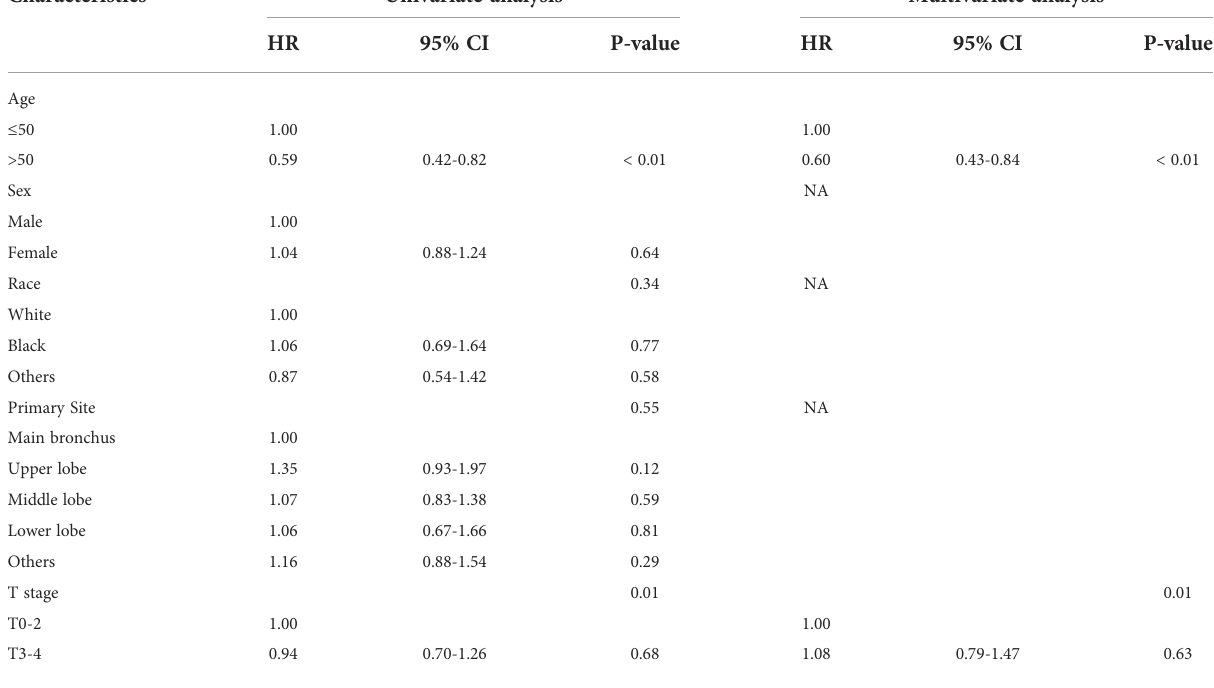
TABLE 3 Univariate and multivariate Cox regression analyses of prognostic factors in the overall LCNEC metastatic patient cohort. Characteristics Univariate analysis Multivariate